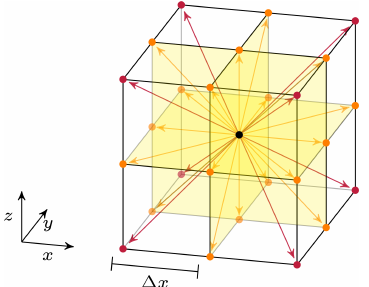
Figure 1. Schematic of three-dimensional velocity lattices. Coordinate-normal planes marked in yellow. Each vector refers to a discrete velocity e ijk as given in Eq. (1). Velocities of the D3Q19 lattice (Qian et al., 1992) with 19 discrete directions are given by orange vectors. Additional velocity directions considered in the D3Q27 lattice are given by red